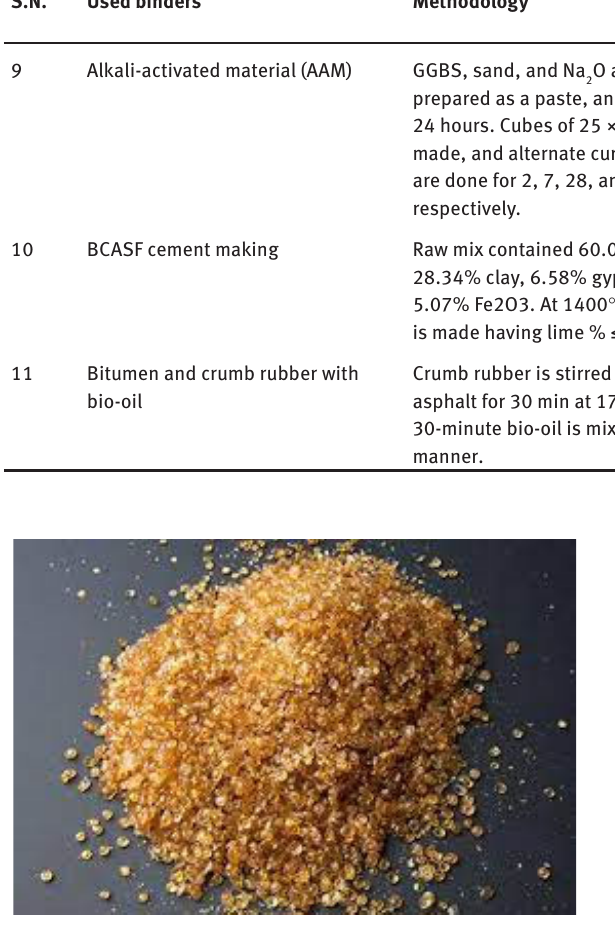
the soil particles together and provides control in rapid volumetric change. The ductility and CBR value also get better when adding more fiber to the soil, as shown in Figure 7. The CBR value increases with the size of the fiber. The optimum fiber dose is found to be 1.2%